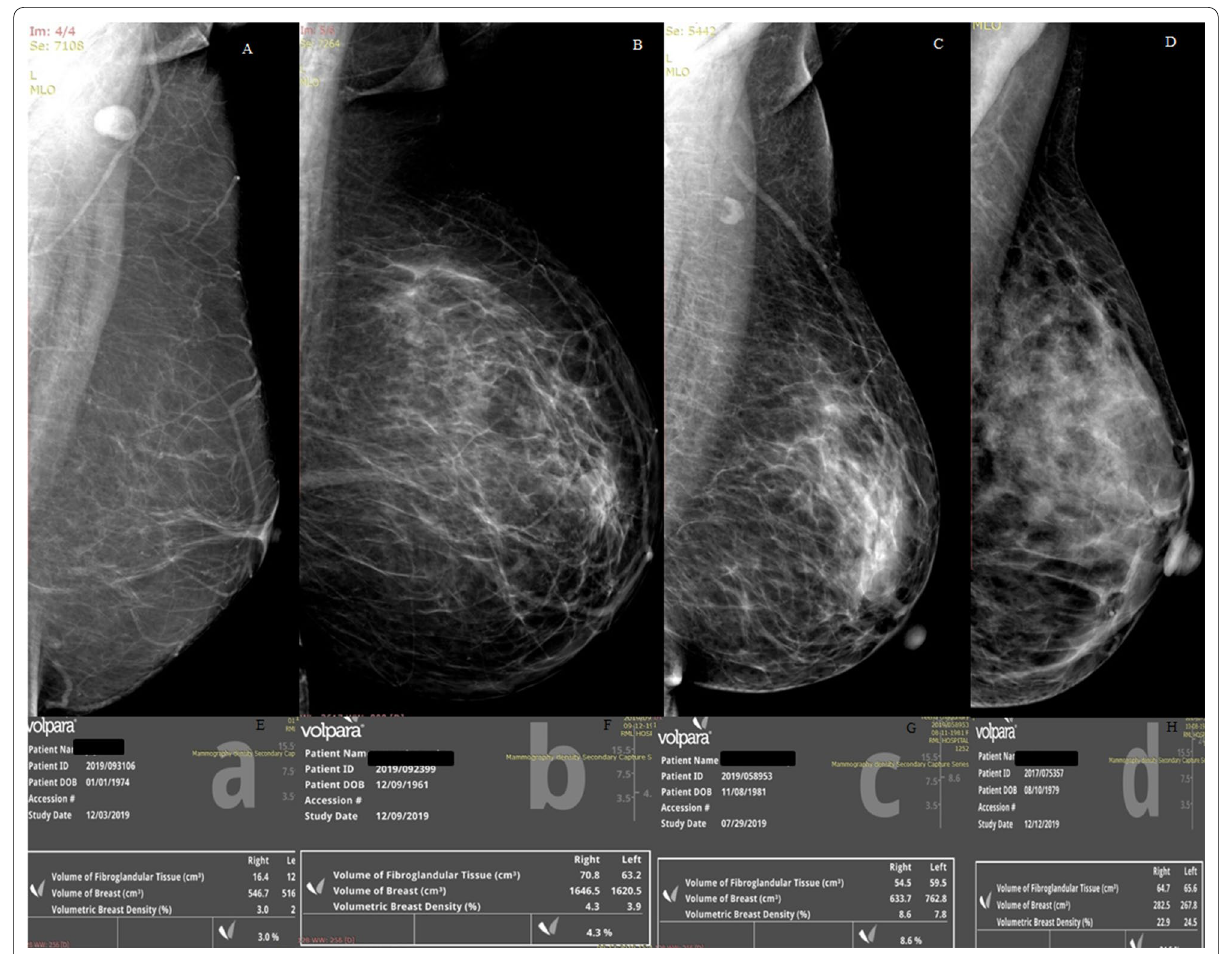
Fig. 1 Medio-lateral oblique views of mammograms showing different Volpara density grades with quantitative volumetric density values: A , E Grade a (3.0%), B , F Grade b (4.3%), C , G Grade c (8.6%) and D , H Grade d